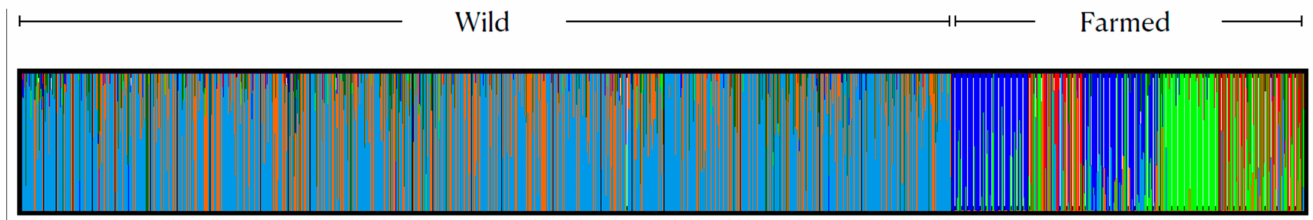
Figure 3. fastSTRUCTURE results for the optimal k = 7 for the jointed dataset that included both the wild and the farmed populations. Populations are ordered as in Figures 1 and